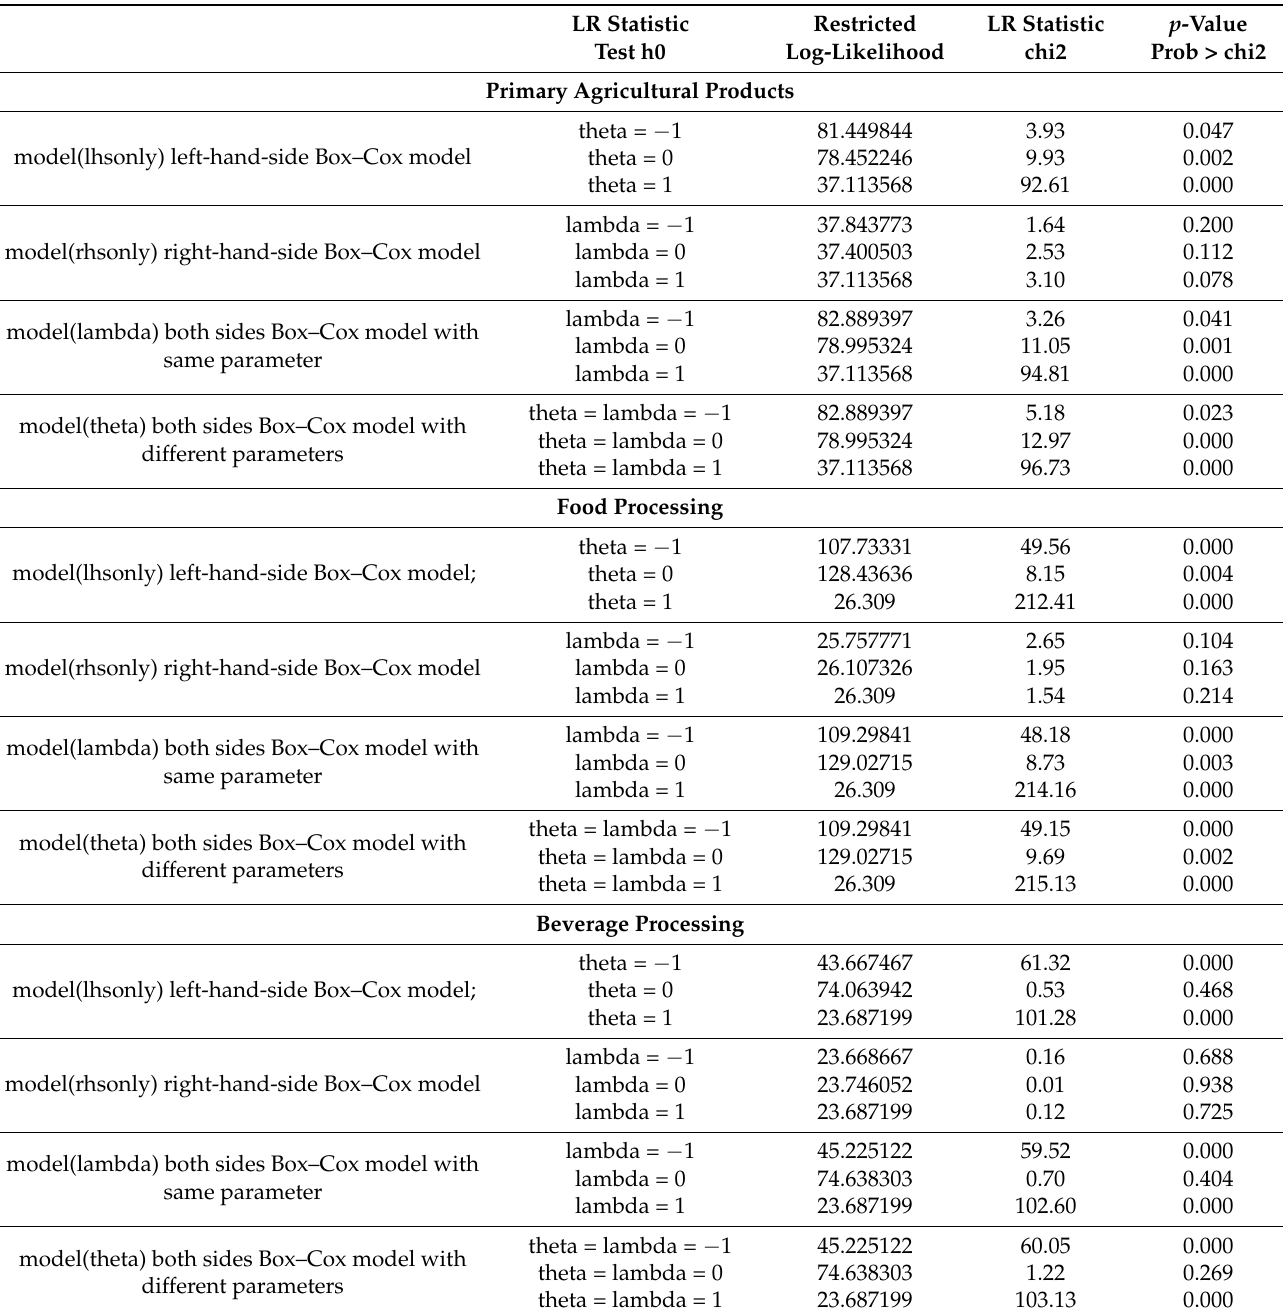
Table 3. Likelihood-Ratio (LR) statistic.